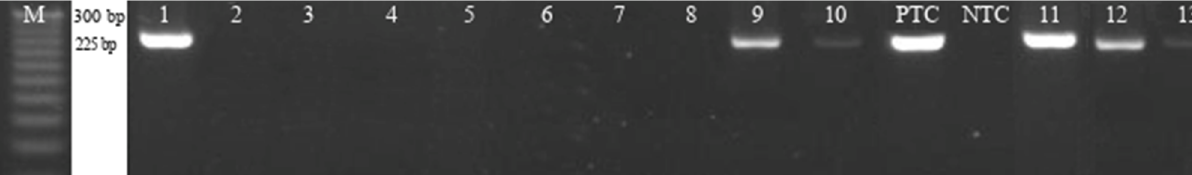
Figure 4. PCR result for the analyzed primers F4/R4. Results of the PCR reaction for the fourth primer pair. Lanes 1 and 11—100% DNA of Rouen duck; lane 2—DNA of KhO-1; lane 3—mix of Pekin duck DNA; lane 4—DNA of Dworka